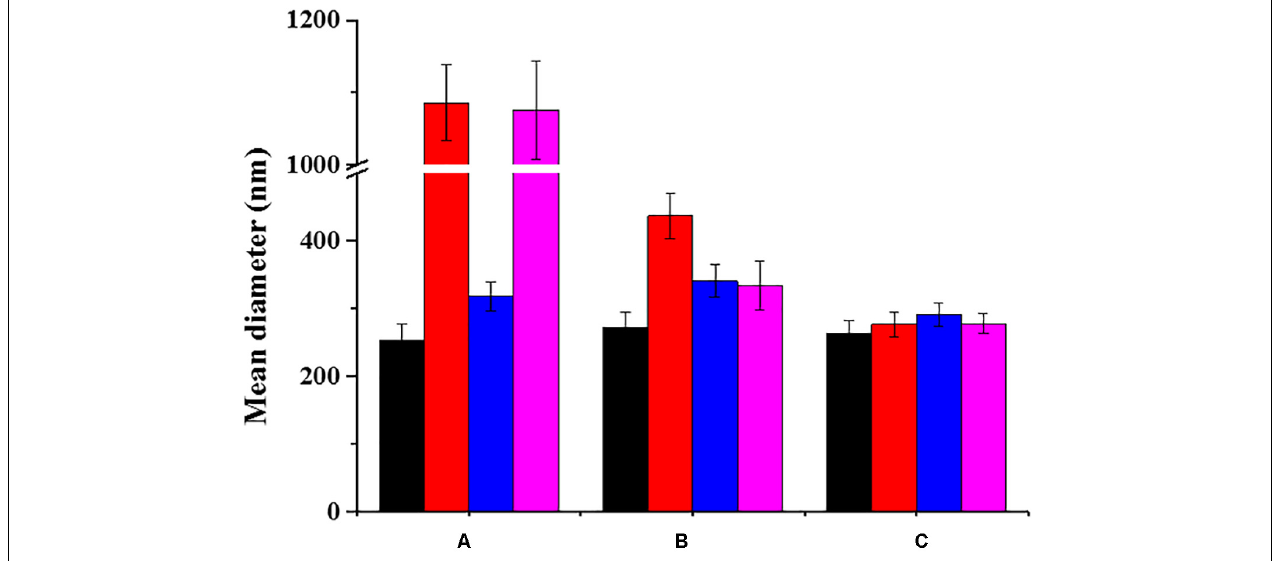
FIGURE 4 | Colloidal stability of nanoMOFs in different media, before (A) and after surface functionalization with DOPC (B) or PEG-lipid conjugates (C) . Mean hydrodynamic diameters of nanoMOF suspensions at 100 µ g/mL were determined by DLS after 6 h incubation at 37 ◦ C. (Black: water; red: PBS; blue: DMEM supplemented with 10v/v% FBS; pink: DMEM without